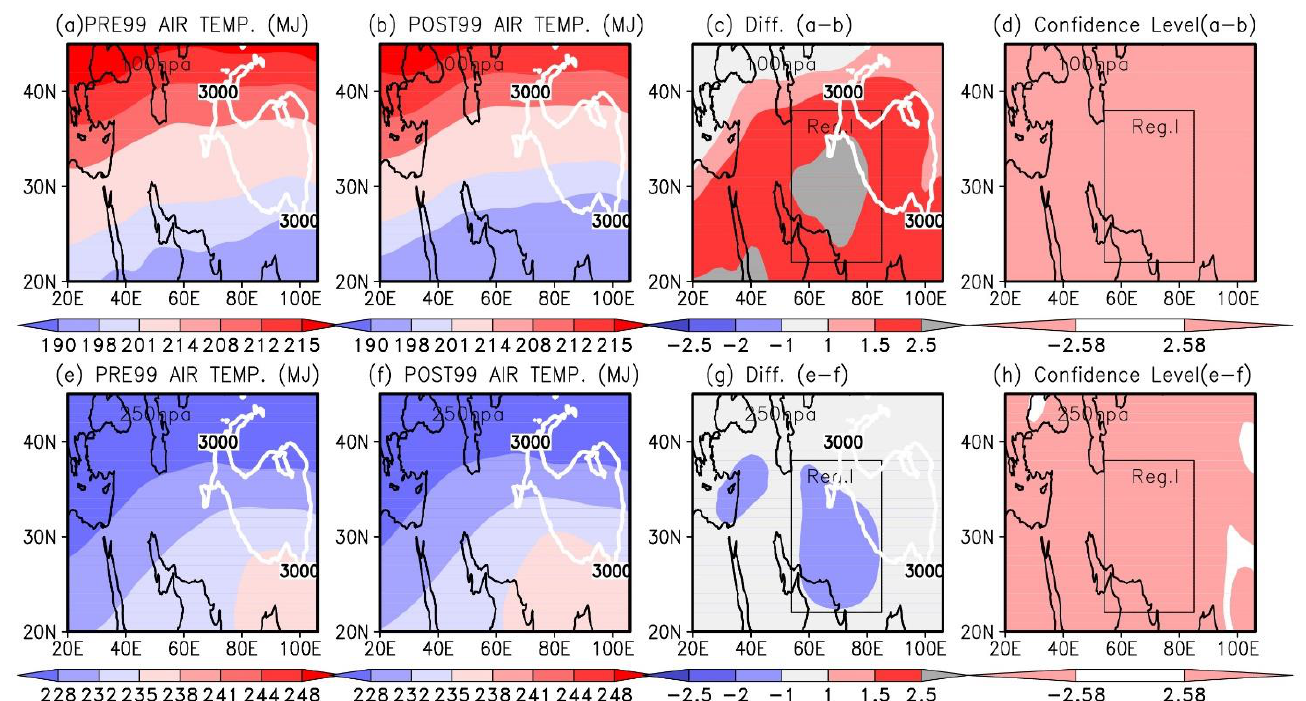
Figure 1. MJ TT (in K) over 100 hPa for the PRE99 ( a ) and POST99 ( b ) periods. ( c ) What separates ( a ) from ( b ), i.e., (a) − (b). ( d ) regions (shaded) showing that ( c ) is significantly different from zero at a 99% level. ( e – h ) is like ( a – d ) but for 250 hPa level. The white contour denotes the topography isoline of 3000 m.